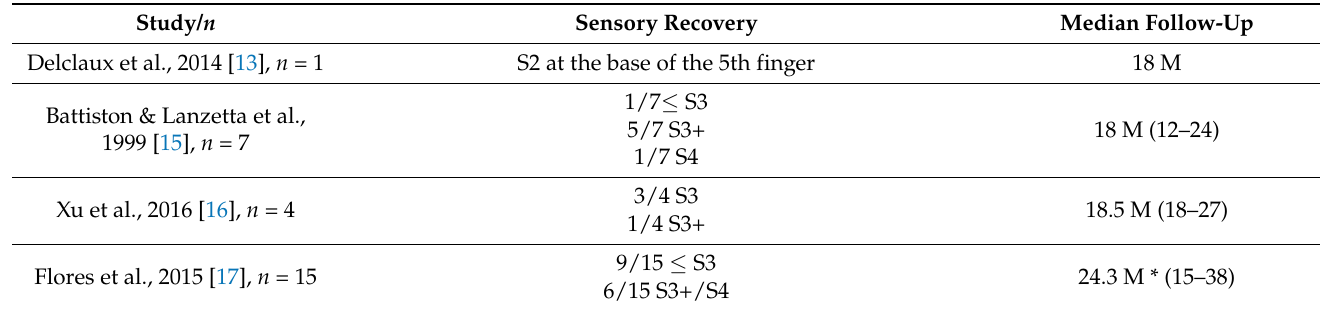
Table 4. BMRC assessment of sensory